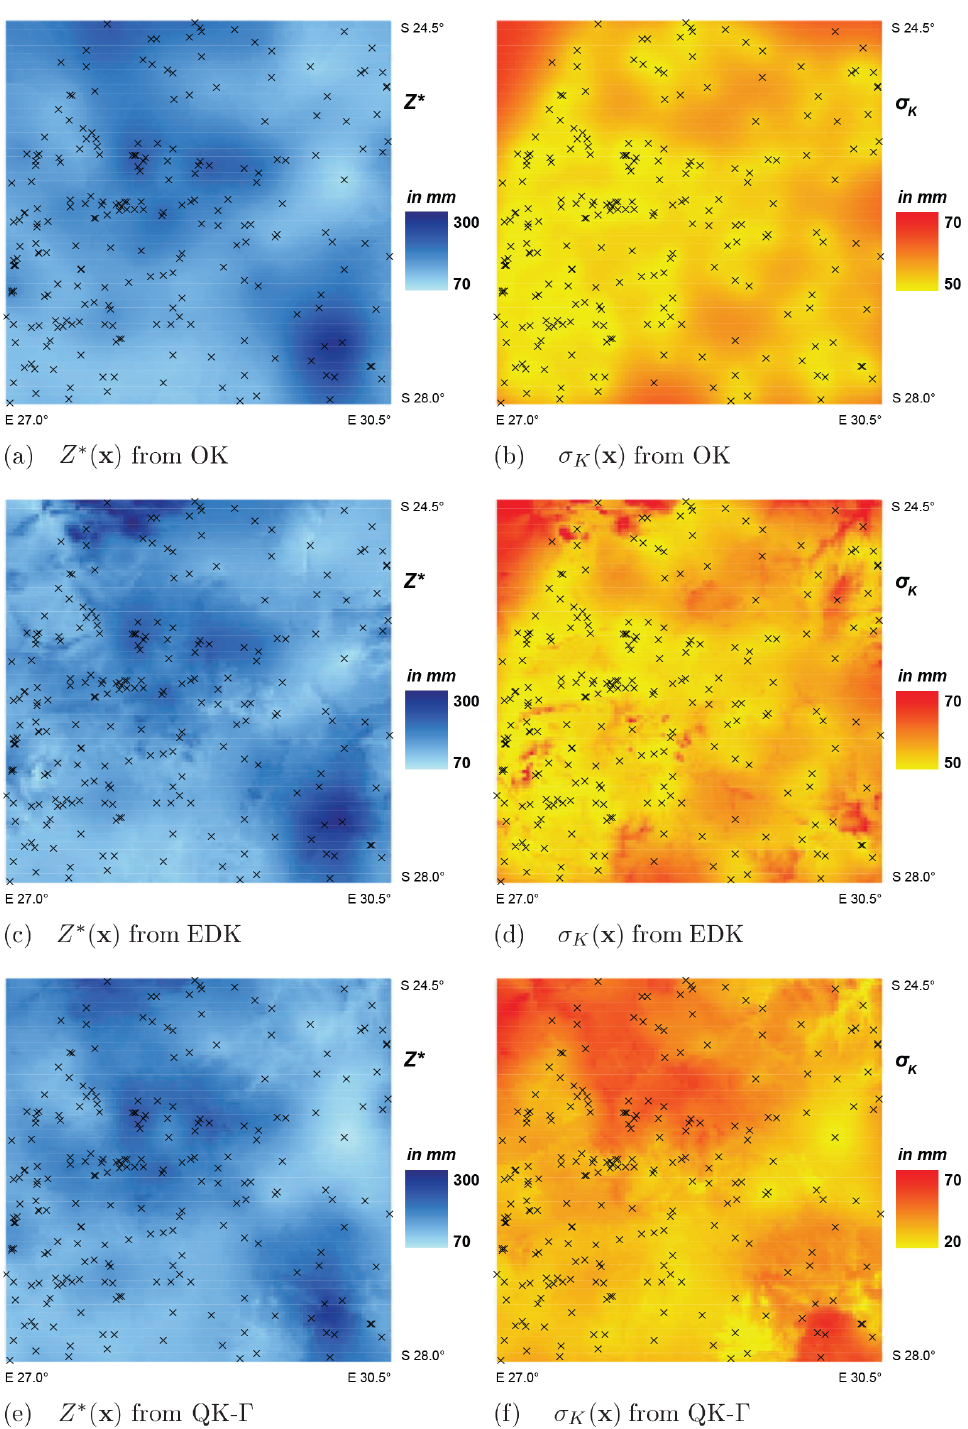
Figure 7. Spatial patterns of the estimator Z ∗ ( x ) and the standard deviation σ K ( x ) from OK, EDK and QK- (cid:48) for January 1996. Note that crosses indicate positions of